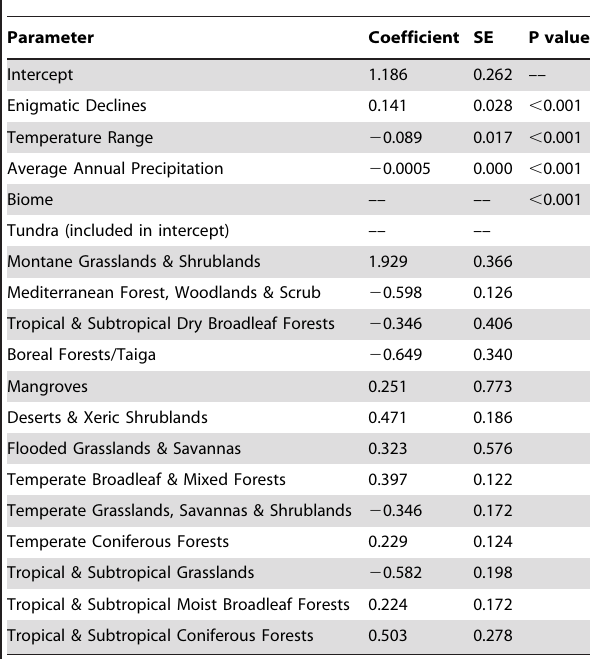
Table 3. Significant parameters in the regression model using Batrachochytrium dendrobatidis ( Bd ) occurrence and data from wild-occurring amphibians having precise locations in the global Bd database (N= 3,733